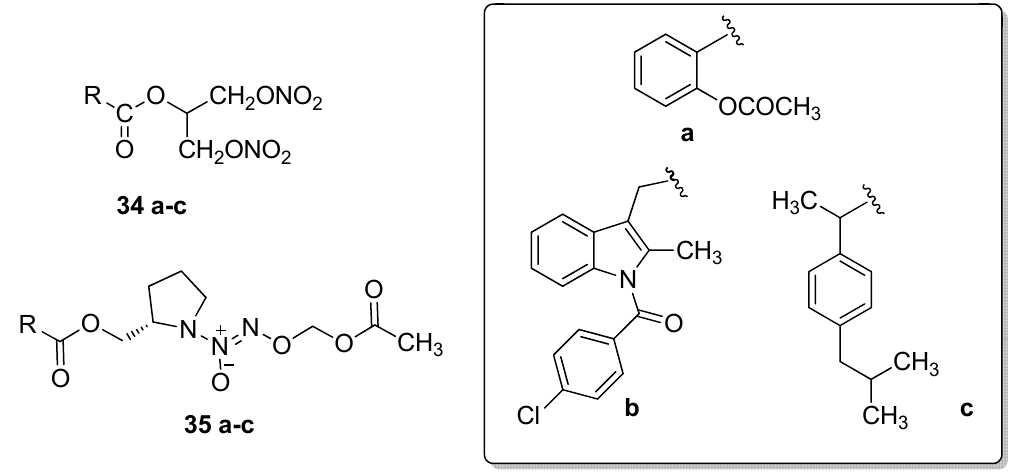
Figure 24. NONO-NSAID hybrid derivatives obtained by Knaus and